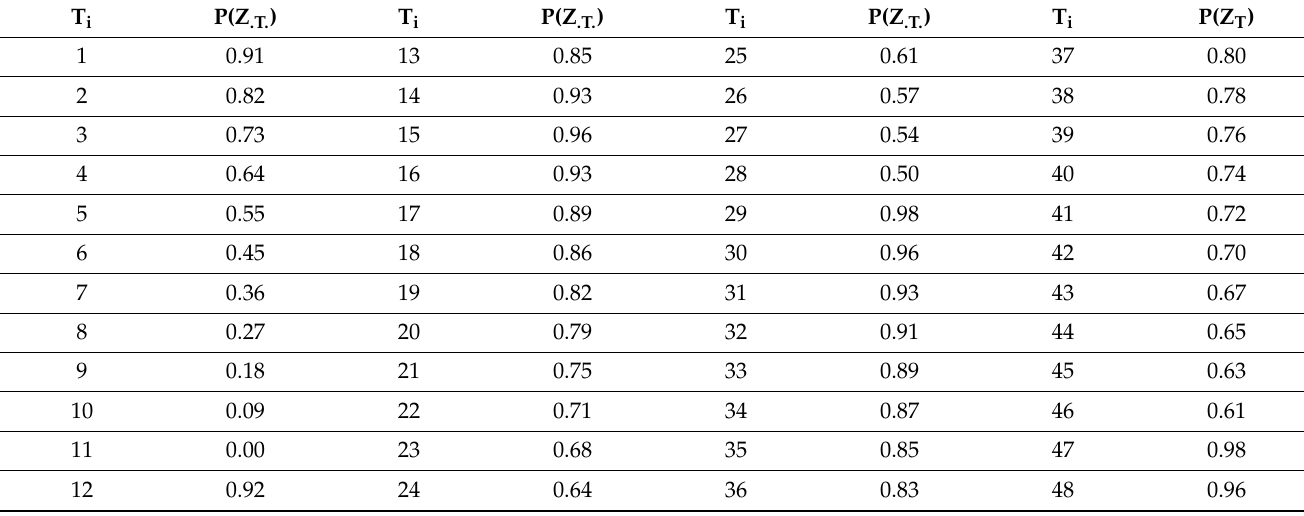
Table 3. Estimation of zone transition